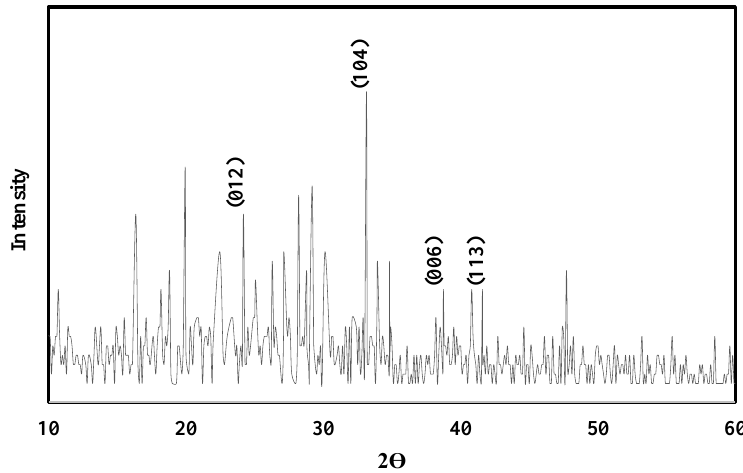
Figure 5. X-Ray diffraction (XRD) pattern of FeNP.